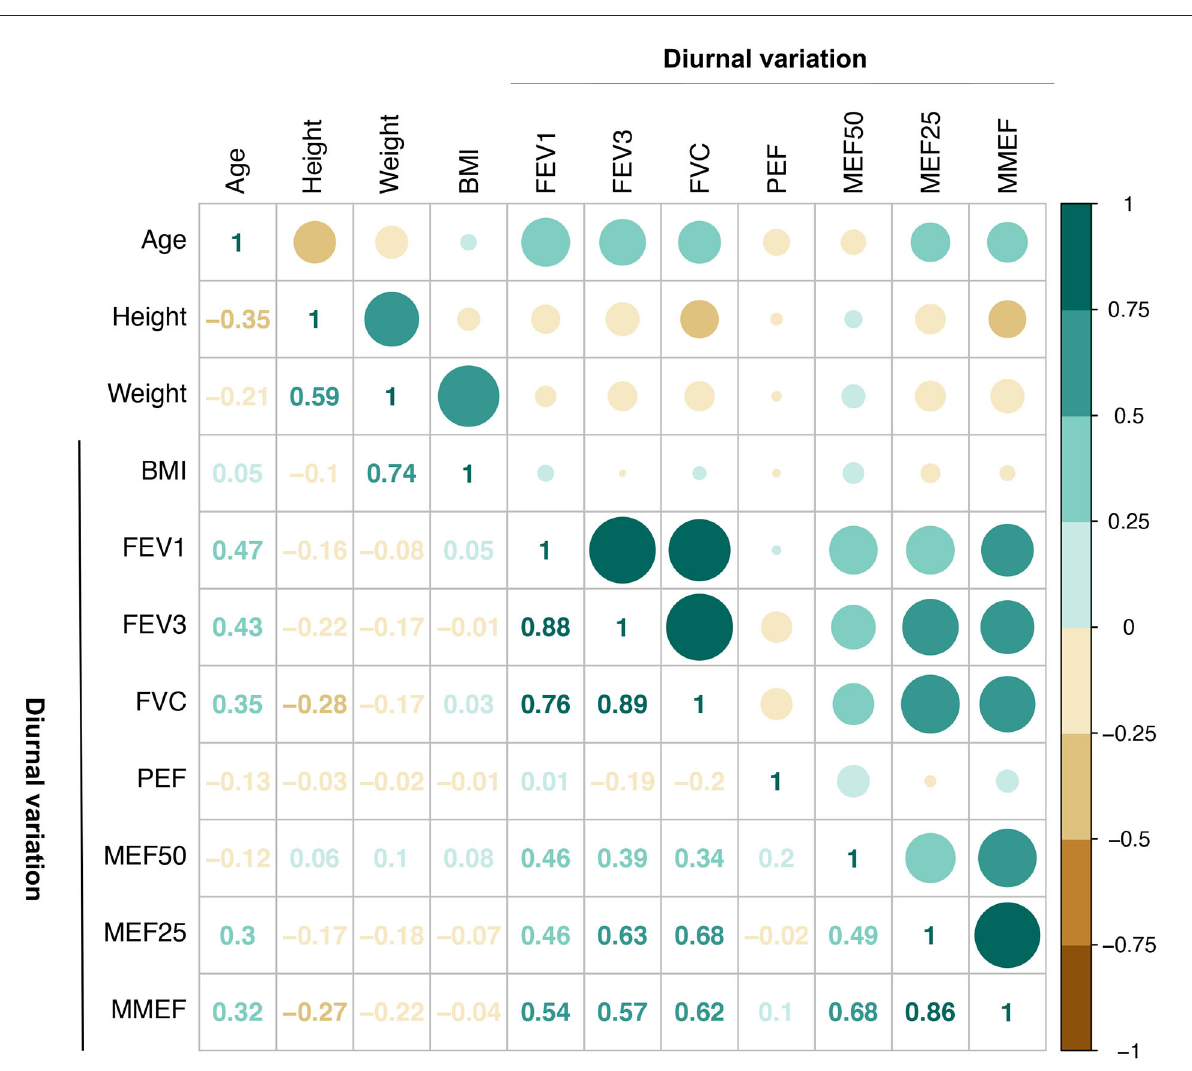
FIGURE5 Correlation of diurnal variation of pulmonary function variable values with age, height, weight, and BMI ( N = 30). A strong relationship between age and FEV 1 as well as FEV 3 ( r = 0.47, P = 0.0109 for FEV 1 and r = 0.43, P = 0.0215 for FEV 3 ) was found. There was no significance between age and FVC, PEF, MEF50, MEF25, and MMEF ( P > 0.05 for all). No significant correlations were also found among height, weight, or BMI and both large- and small-airway function variables ( P > 0.05 for all). BMI, body mass index; FVC, forced vital capacity; FEV 1 , forced expiratory volume in 1s; FEV 3 , FEV in 3s; MEF50, forced expiratory flow at 50% of forced vital capacity; MEF25, forced expiratory flow at 75% of forced vital capacity; MMEF, forced expiratory flow between 25 and 75%; PEF, peak expiratory